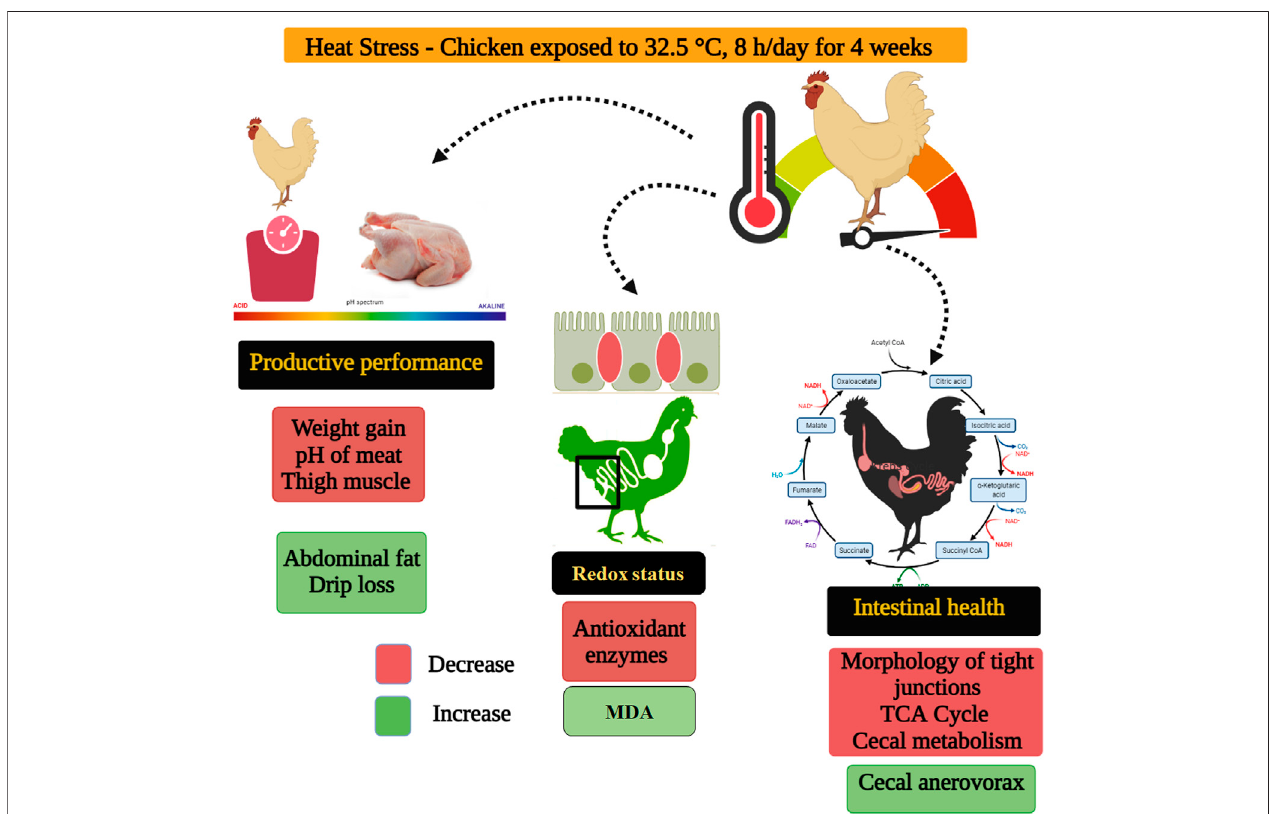
FIGURE 6 | Proposed mechanism of heat stress on indigenous broilers (Huaixiang